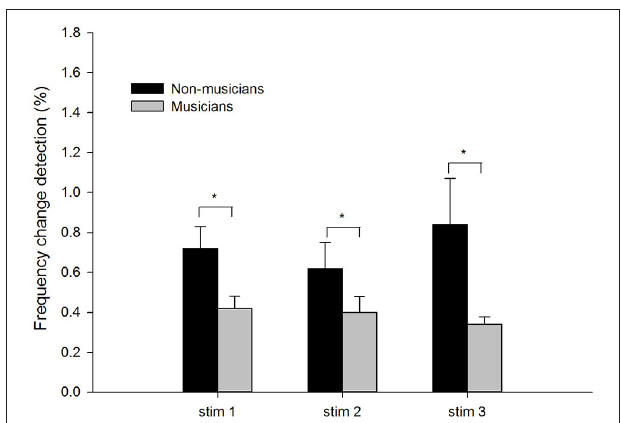
FIGURE 1 | The frequency detection thresholds of musicians and non-musicians for the three stimulus conditions: tone stimuli containing frequency changes (Stim 1), tones containing frequency changes with low-level noise (Stim 2), and tones containing frequency changes with high-level noise (Stim 3). The error bars indicate standard errors of the means. Asterisks denote significant differences between the groups ( p <